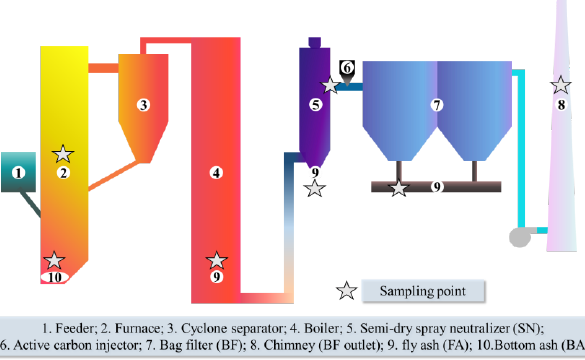
Figure 1. Schematic diagram of the studied circulating fluidized-bed-system.